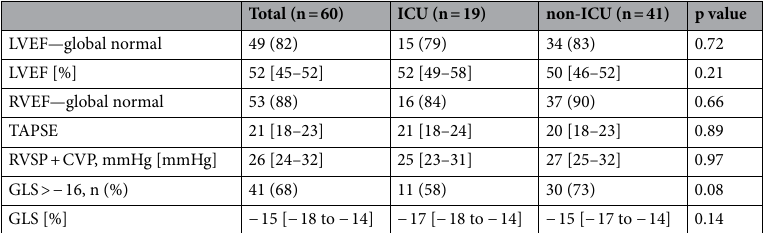
Table 3. Comparison of follow-up TTE between patients treated in the ICU vs. general ward. Values are presented as mean ± standard deviation, number of patients (percentage) or median [interquartile range]. LVEF = left ventricular ejection fraction; RVEF = right ventricular ejection fraction; TAPSE = tricuspid annular plane systolic excursion; RVSP = right ventricular systolic pressure; CVP = central venous pressure; GLS = global longitudinal